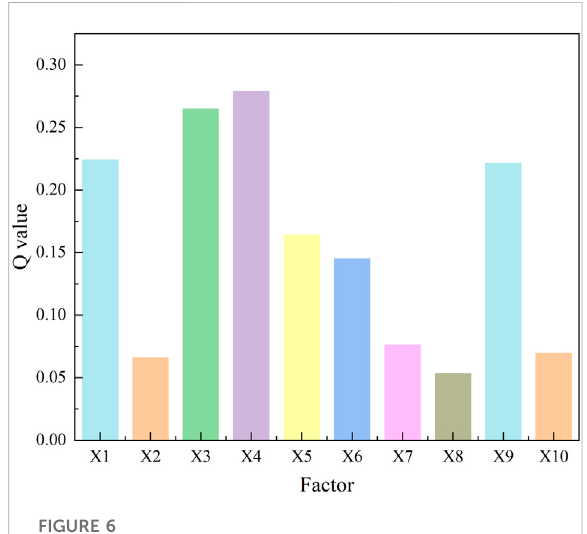
FIGURE 6 In fl uence factor Q value of NDVI in the three northeast